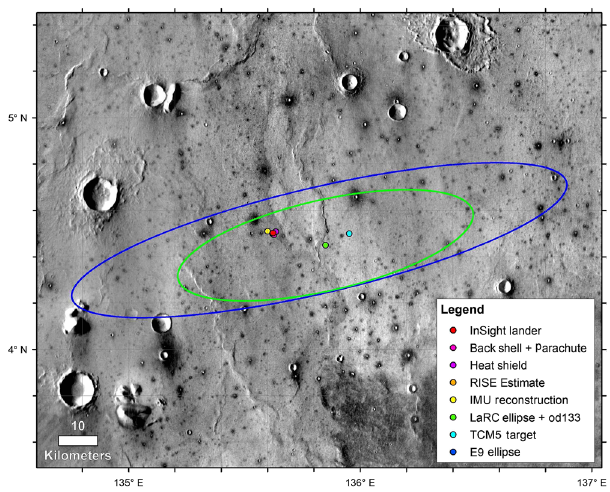
Fig. 2 InSight landing ellipses and spacecraft locations. Image shows the landing ellipse (E9, dark blue, 130 km × 27 km), with trajectory correction maneuver 5 (TCM5) course adjusted target (green dot), the last orbit determination solution and ellipse (LaRC green, 77.4 km× 23.2 km), the extrapolated inertial measurement unit (IMU) surface location, the RISE estimate from Sol 1 (4.49751° ± 0.00471°N, 135.6178693° ± 0.000337°E, hidden behind the lander dot, red), and HiRISE-based location from December 6th, 2018. Background image mosaic is from the daytime Thermal Emission Imaging System (THEMIS) infrared global mosaic at 100 m/pixel. The dominant surface is smooth Early Amazonian-Hesperian plains deformed by north-trending wrinkle ridges (suggesting subsurface basalt fl ows) with large impact craters 2,3 . Craters larger than around 40